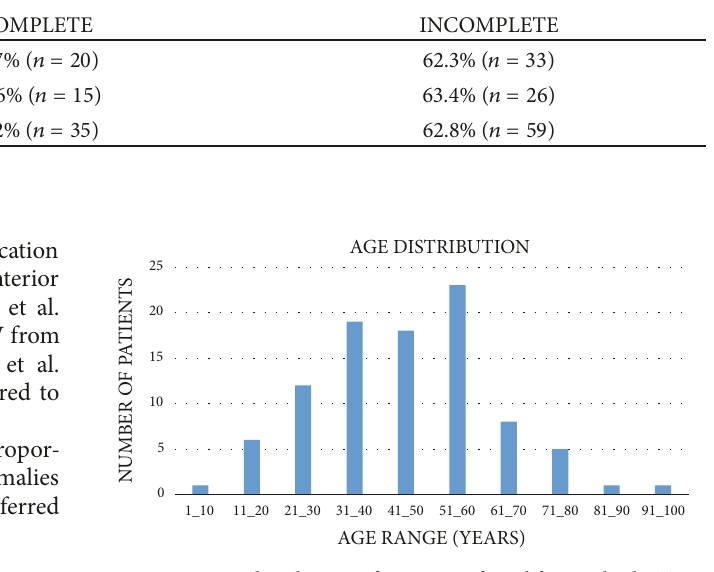
Figure 1: Age distribution of patients referred for cerebral